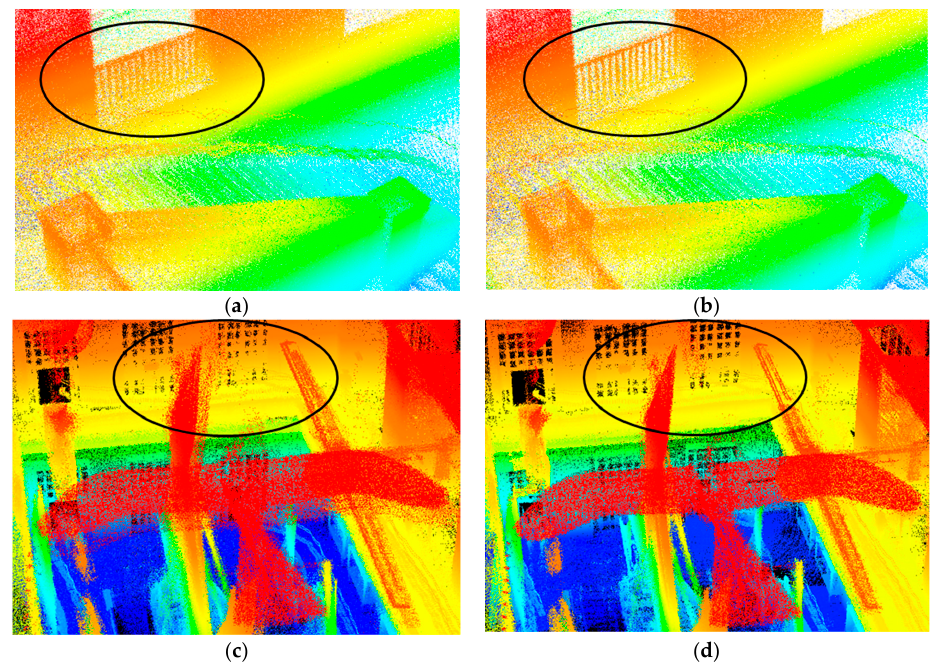
Figure 21. Snapshots of the point cloud of Cartographer dataset before (left) and after optimization (right). ( a )( c ) the point clouds before optimization; ( b )( d ) the point clouds after optimization.